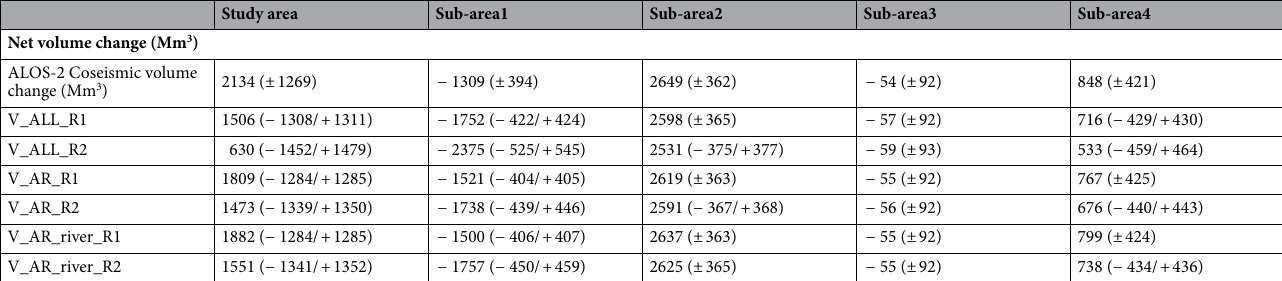
Table 2. Net volume change (Mm 3 ) correlating the coseismic volume change due to the earthquake and the earthquake-induced landslides volume. The data are reported both for the whole study area and for the three sub-areas identified that represent portions of the study area characterized by different uplift and subsidence rates (see Fig. 7). The coseismic volume change from ALOS-2 is reported for comparison in the first line. R1 global relationship for all landslide types, R2 relationship for mixed bedrock and soil landslides in the Himalaya 36 . The range of variation is propagated from the uncertainty on the ALOS-2 coseismic volume change and landslide